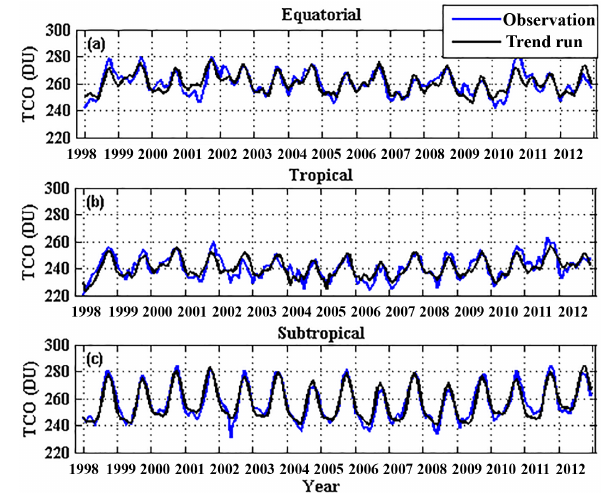
Figure 5. Time evolution of monthly mean total ozone values (blue) over the equatorial (a) , tropical (b) and (c) subtropical regions. The black lines represent TCO values as calculated by the Trend-Run